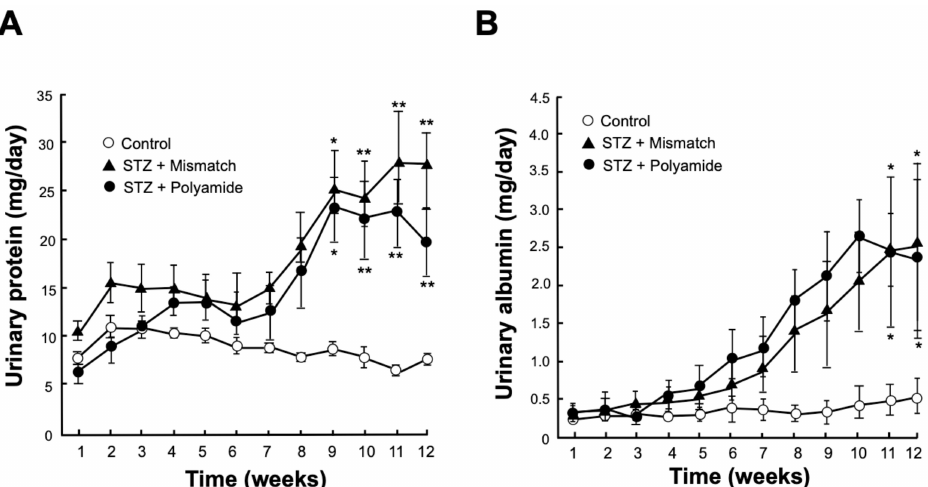
Figure 5. E ff ects of pyrrole-imidazole (PI) polyamide targeting TGF- β 1 or Mismatch PI polyamide on urinary excretions of protein and albumin in streptozotocin (STZ) diabetic rats. Diabetes was induced in male Wistar rats by single intraperitoneal injection of 60 mg / kg body weight of STZ. Control rats were intraperitoneally injected with 1 mL of 0.1% acetic acid. Urinary protein ( A ) and urinary albumin ( B ) were measured in 24-h urine collected in metabolic cages for 12 weeks. Five milligrams of PI polyamide targeting TGF- β 1 dissolved in 1 mL of 0.1% acetic acid was intraperitoneally injected twice a week. Data are the mean ± SEM (n = 5). * p < 0.05, ** p < 0.01 versus Control.